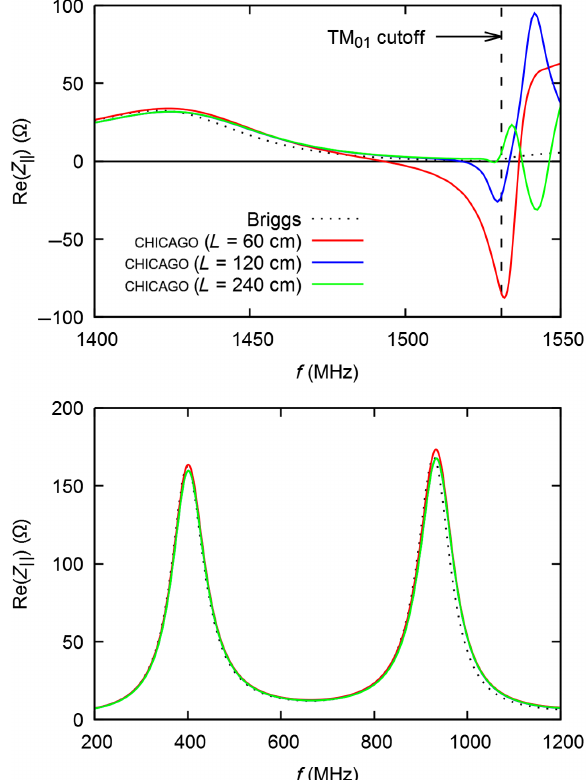
FIG. 3. Z k plotted as a function of frequency for an idealized pillbox gap with b ¼ 7 . 5 cm, d ¼ 3 . 5 cm, R ¼ 30 cm, and Z =Z ¼ 1 = 4 . Results are shown for the theory of Briggs (dotted s o line) and CHICAGO simulations (solid lines) with L ¼ 60 cm (red), 120 cm (blue), and 240 cm (green). Top: detail in the region close to TM 01 cutoff frequency. Bottom: effect of varying L at a lower